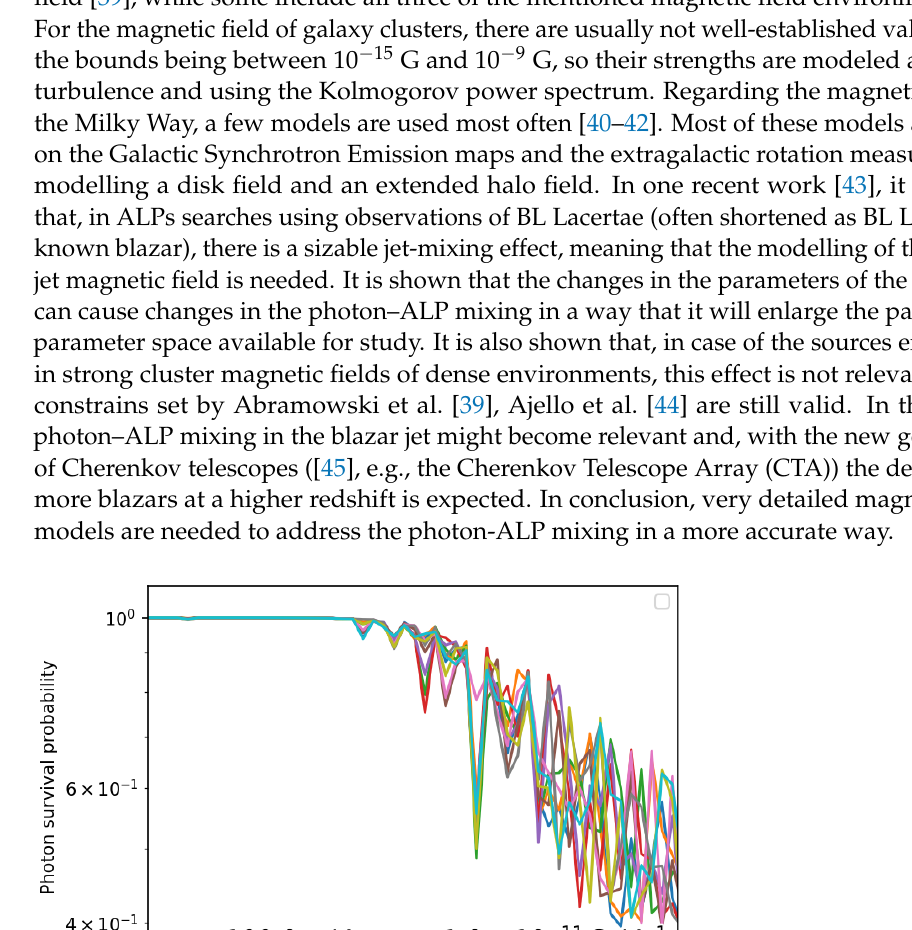
Figure 3. Photon survival probability for m a = 100 neV and g a γγ = 1 the GAMMAALPs code: https://github.com/me-manu/gammaALPs (accessed on 3 June